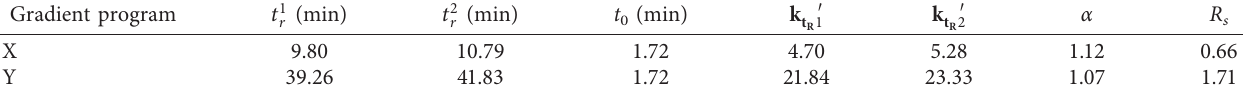
Table 7: Enantiomer separation of rac-citronellal on the MMIP B column using the gradient elution method. Gradient program